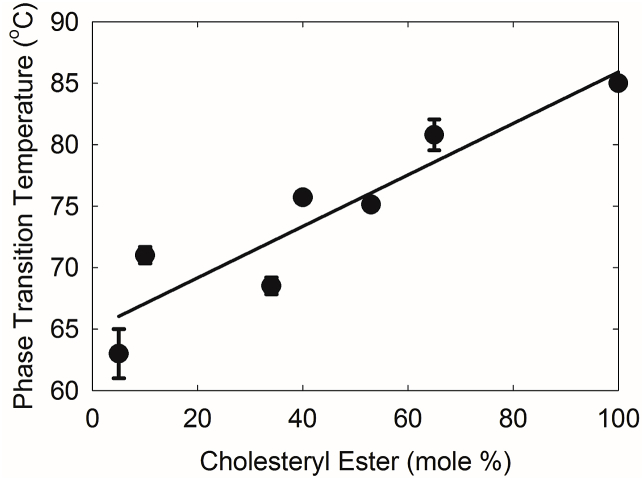
The change in the phase transition temperature with the mole % cholesteryl behenate mixed with oleyl oleate. The line is the linear regression fit to the data. The phase transition temperature is the temperature at the midpoint of the phase transition from an ordered gel phase to a disordered liquid crystalline phase.